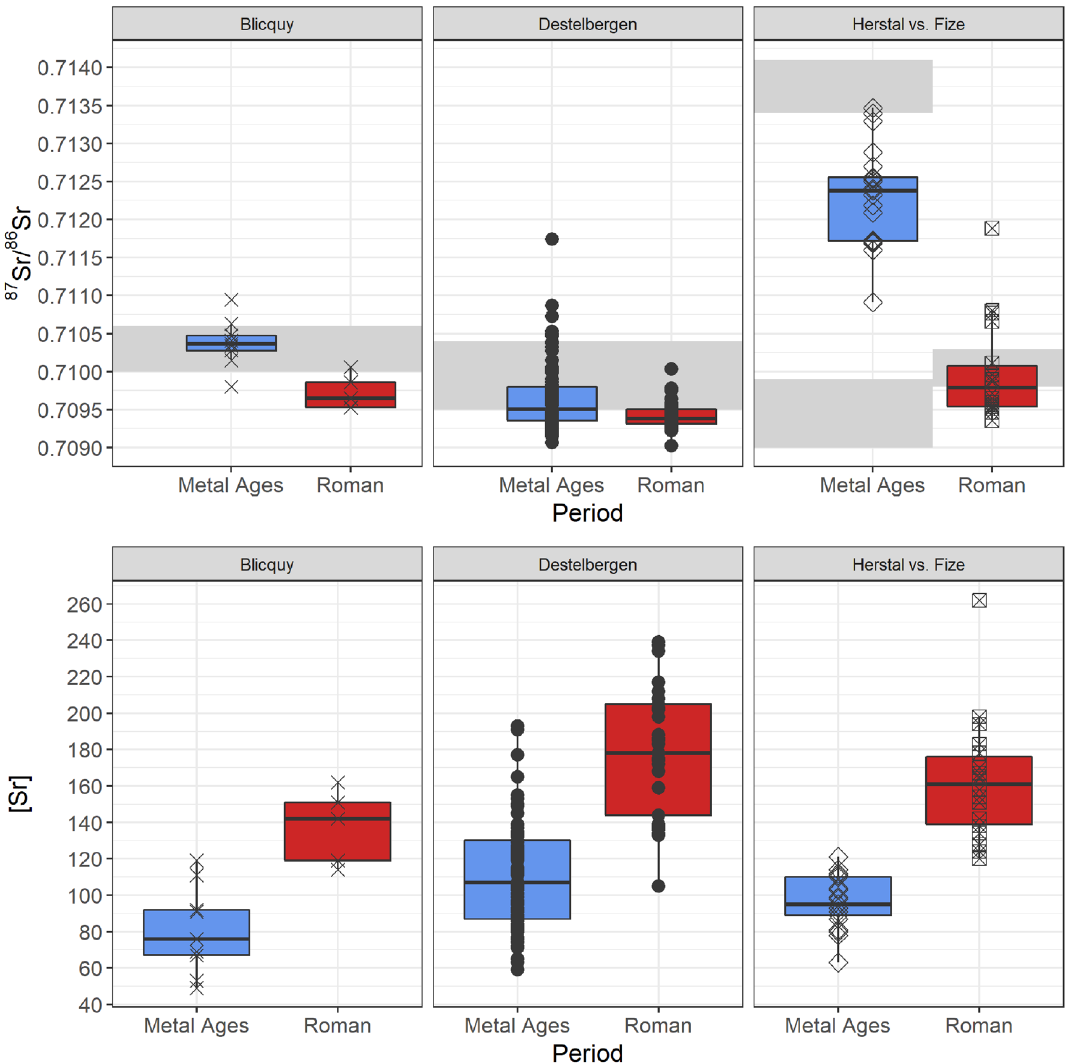
Figure 2. Comparison of 87 Sr/ 86 Sr and [Sr] between the Metal Ages and Gallo-Roman buried individuals of Destelbergen, Blicquy, Herstal 8 and Fize-le-Marsal. The available 87 Sr/ 86 Sr baselines are indicated in grey. The baseline of Herstal includes two isotopically very different geological formations. [Sr] normalized to 40 wt% Ca. (graph created using R Studio (R version 4.0.2), www.r- proje ct.